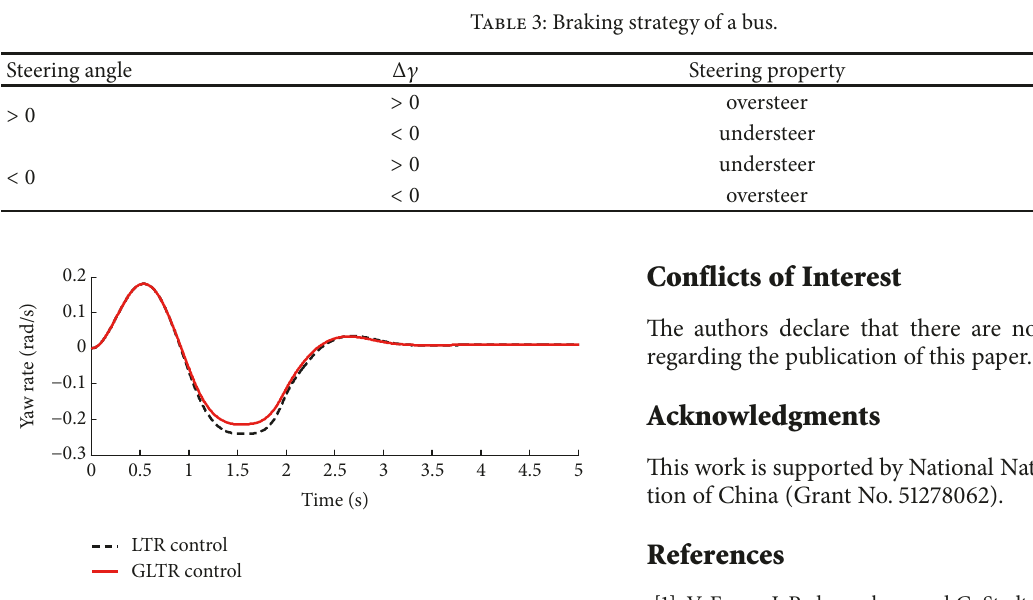
Figure 16: Comparison result of the yaw rate in the 100-km/h Sindwell